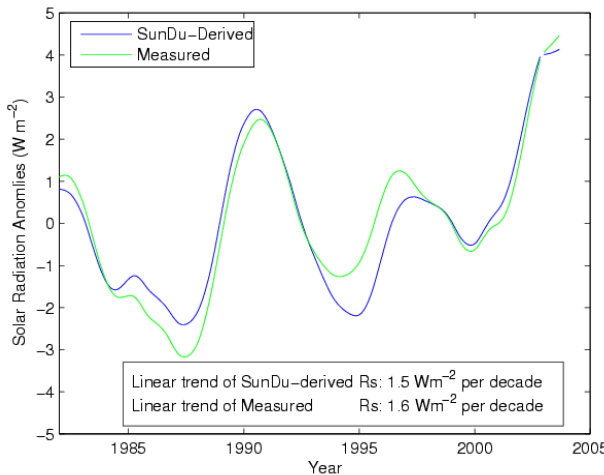
Fig. 6. Comparison of five-year smoothed monthly anomalies of SunDu-derived with directly-measured R s averaged over 86 stations in Europe (Table 1). The breakpoint in 2003 reflects a break in data availability. The linear trends are calculated annual anomalies rather than five-year smoothed data.